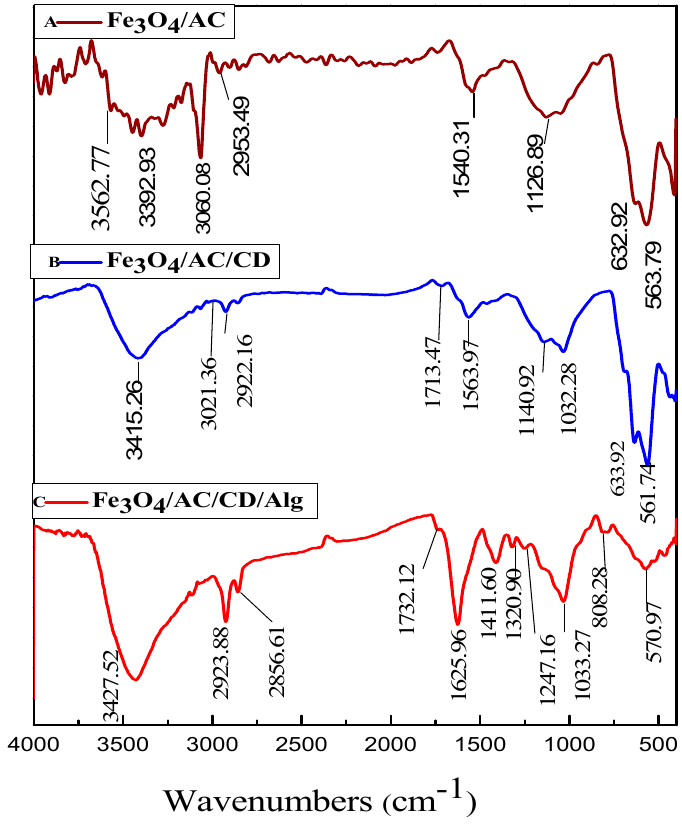
Figure 4. FTIR patterns of Fe 3 O 4 /AC ( A ), Fe 3 O 4 /AC/CD ( B ) and Fe 3 O 4 /AC/CD/Alg ( C ).